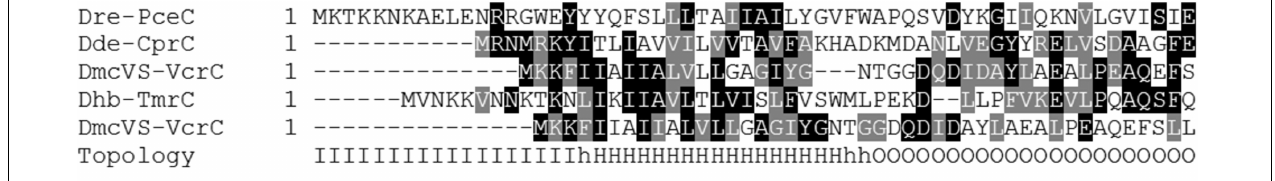
FIGURE 1 | Sequence alignment of four typical members of the RdhC enzyme family: PceC (CAG70347.1) of Dehalobacter restrictus (Dre); CprC (AAD44543.2) of Desulfitobacterium dehalogenans (Dde); VcrC (ACZ62389.1) of Dehalococcoides mccartyi strain VS (DmcVS); TmrC (WP_021315090.1) of Dehalobacter sp. strain UNSWDHB (Dhb). The predicted topology is indicated under the alignment: O, outside; I, inside; H, transmembrane α -helices. The bold line above the alignment indicates the predicted FMN-binding domain (FBD, smart00900) with the conserved threonine residue predicted to bind FMN covalently (indicated by the asterisk).